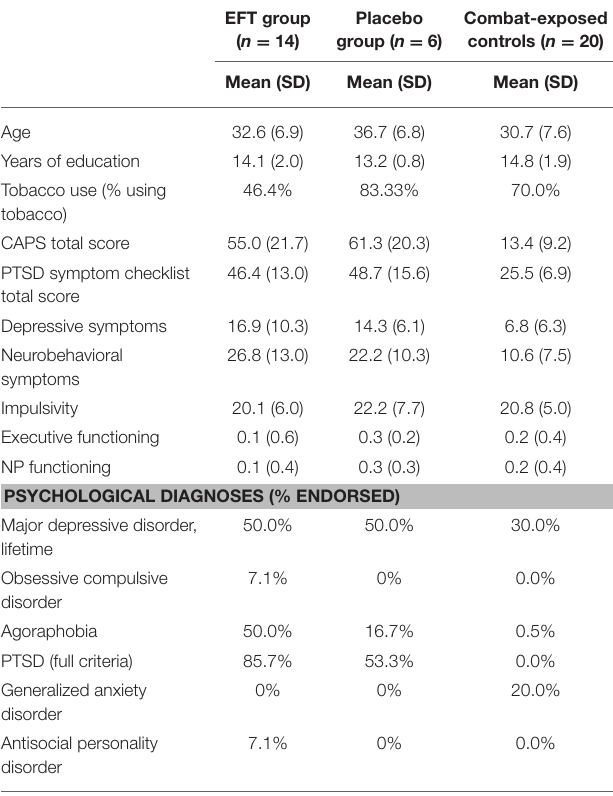
TABLE 1 | Descriptive statistics at